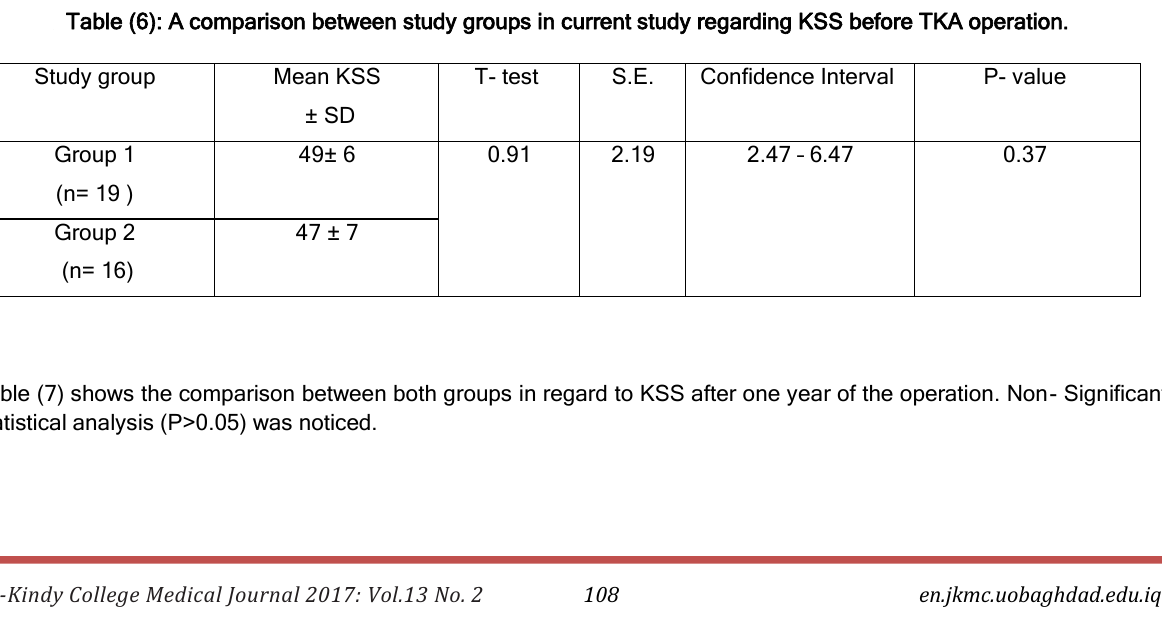
Table (6): A comparison between study groups in current study regarding KSS before TKA operation.